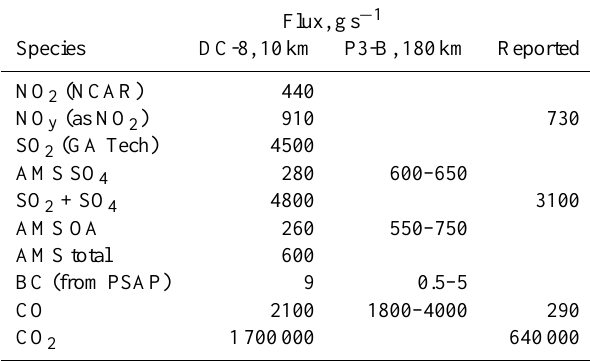
Figure 8. Vertical profile data from the DC-8 near the oil sands plume. Aerosol backscatter ratios are from 18:06:20 (near the peak of the plume downwind of the sampling loop) and 18:10:20 (near where the lidar curtain crossed the sampling loop). Other data are from the descent into (thin lines) and ascent out of (thick lines) the sampling leg, which occurred upwind of the emissions sources. The choice of mixed layer depth, z m , for the flux calculation was based on the lidar data. Potential temperature indicates a surprisingly sta- ble boundary layer. In contrast, water vapor and RH suggest that the mixed layer extends to near cloud base at 2.0 to 2.2km. Table 1. Fluxes calculated from the DC-8 loop around the oil sands facilities on 10 July and the P3-B plume penetration on 28 June. Estimated errors are roughly a factor of 2 for the DC-8 flyby (Ta- ble 2) and higher for the P3-B. The latter column includes a range of values since the plume width is ambiguous. See text and Fig. 10b. “Reported” values are from Environment Canada (2008a) and the Greenhouse Gas Inventory (for CO 2 ), reporting year 2008. All sources within the DC-8 loop are included, though the Syncrude and Suncor upgraders are by far the largest.